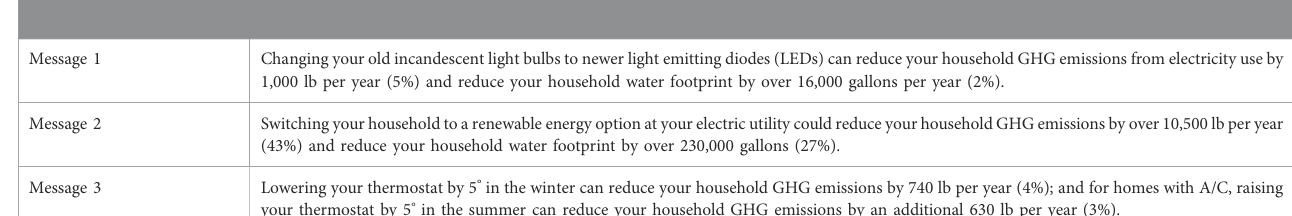
TABLE 4 Sample intervention message feedback to